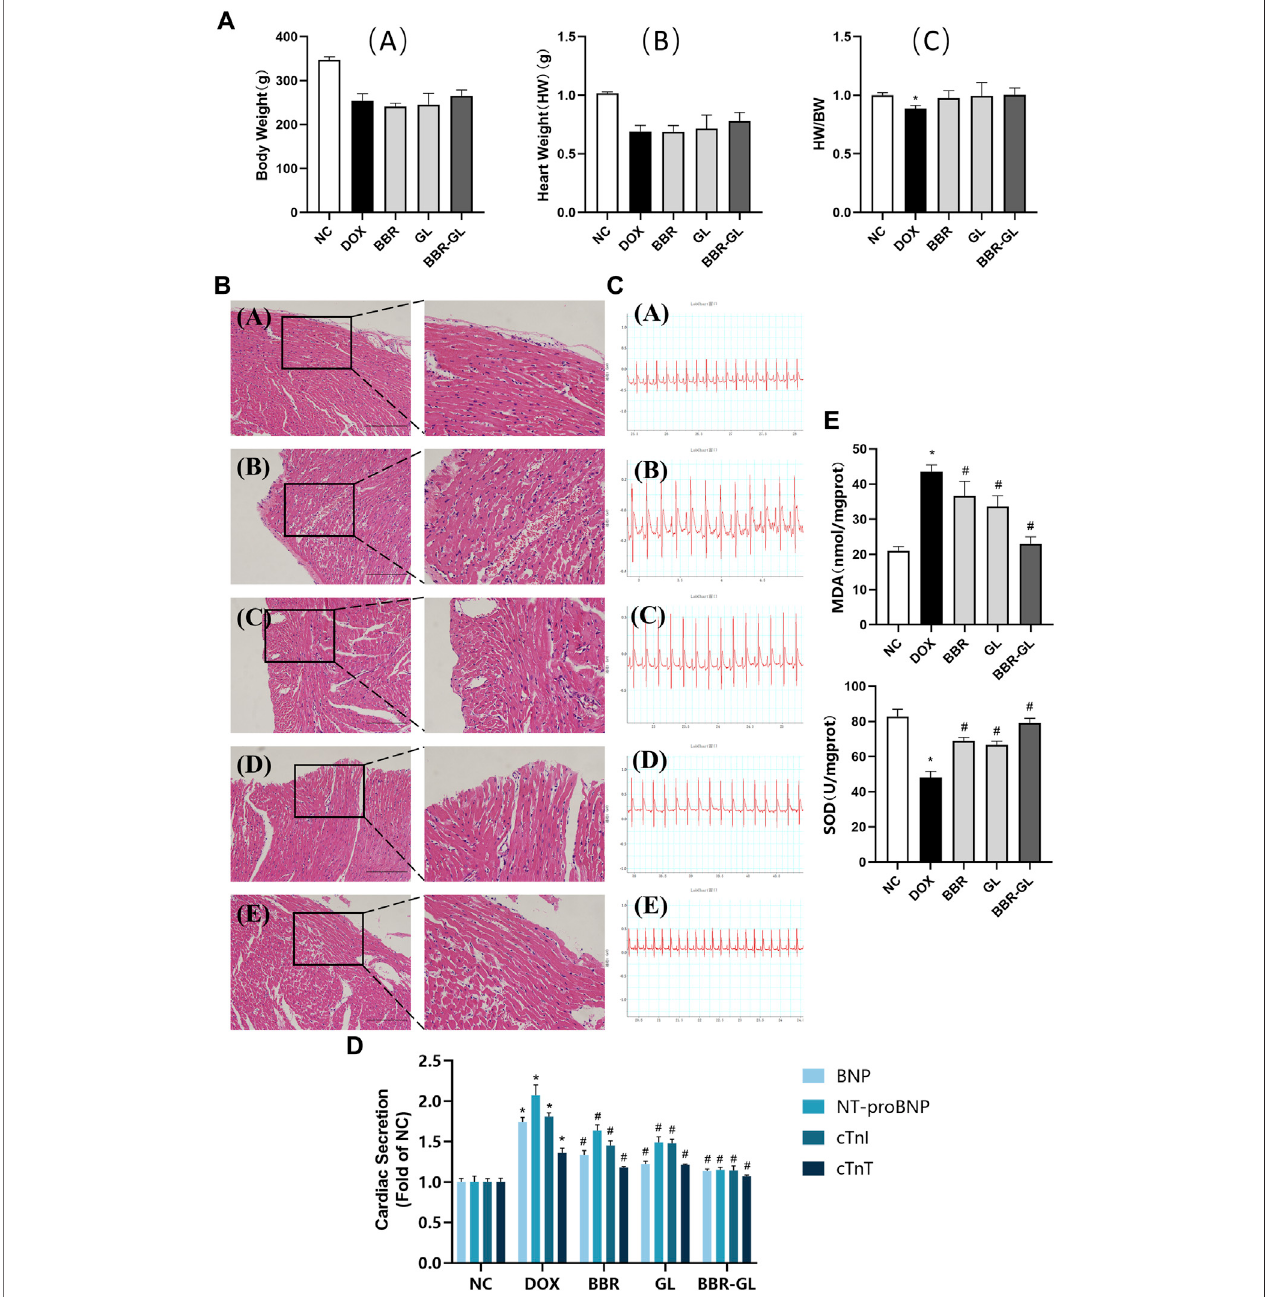
FIGURE 6 | BBR-GL complex enhances the protective effect of BBR and GL against acute DOX-induced cardiac injury. (A) . Effects of DOX, BBR, GL, and their combination on the rat body weight and heart weight. (A) Body weight changes in rats; (B) heart weight changes in rats; and (C) changes of heart weight/body weight ratio. (B) .HEstainingandpartialmagni fi cationof (A) NC, (B) DOX, (C) BBR, (D) GL,and (E) BBR-GL.Scalebar:100 μ m. (C) .ECGof (A) NC, (B) DOX, (C) BBR, (D) GL, and (E) BBR-GL. (D) .CardiacsecretionofBNP,NT-proBNP,cTnI,andcTnTinratplasma. (E) .MDAandSODlevelsinratheart. p p < 0.05vs.NCgroup;# p < 0.05 vs. DOX group. Data are presented as mean ±